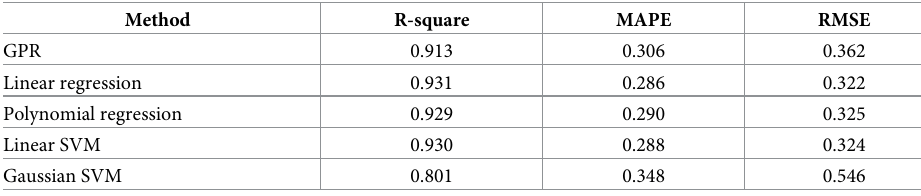
Table 4. Comparison between different methods for T